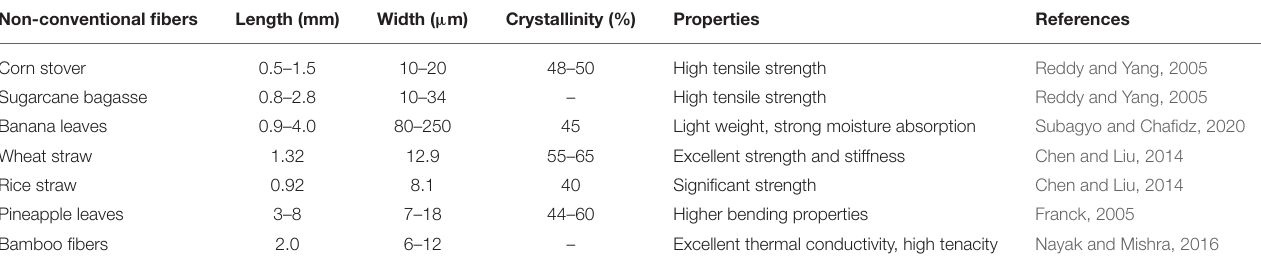
TABLE 3 | Characteristics of non-conventional fibers derived from agro-waste. Non-conventional